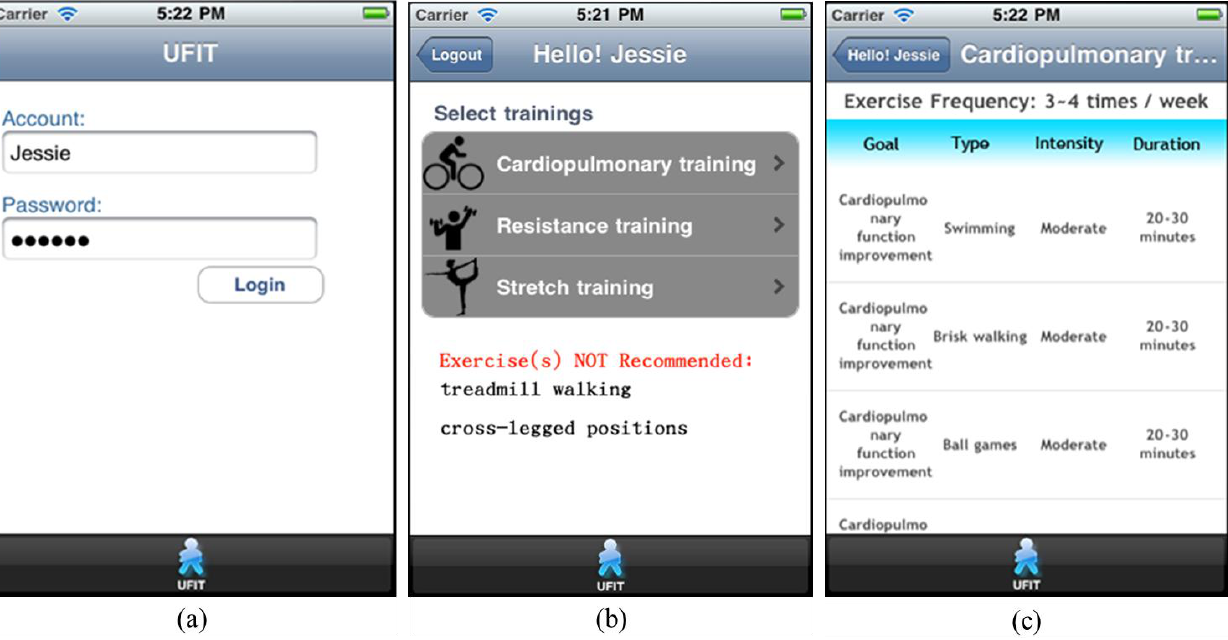
13. ( a ) UFIT login page; ( b ) Customized exercise plan generated; ( c ) Cardiopulmonary training in the customized exercise